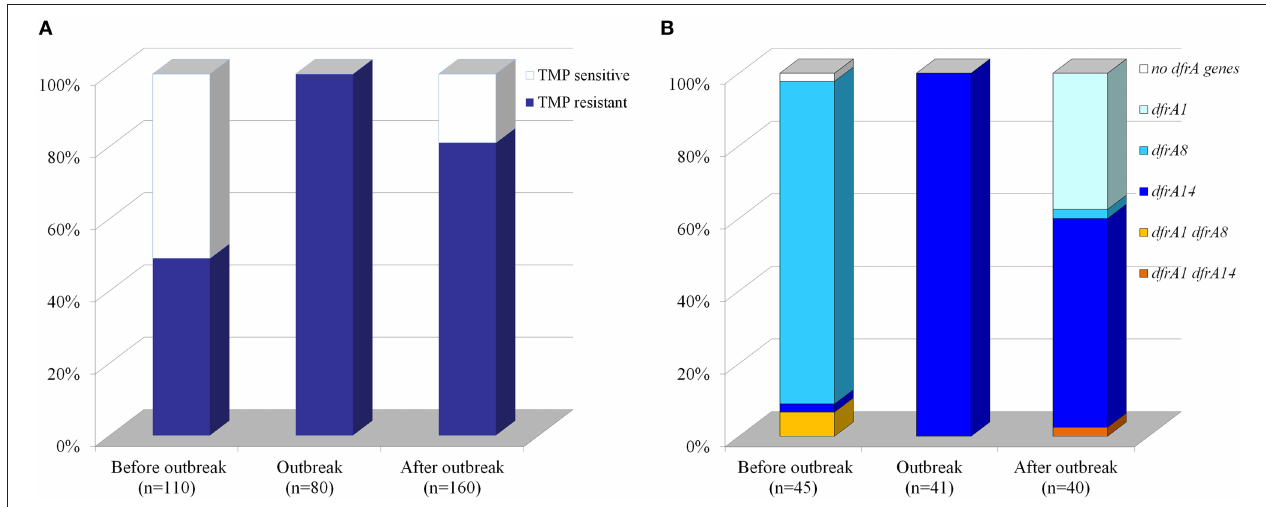
FIGURE 1 | Distribution of trimethoprim-resistant strains and trimethoprim-genetic markers among Chilean Shigella sonnei isolates. (A) Percentage of TMP-susceptible and–resistant strains. Susceptibility to TMP was measured by disk diffusion in a total of 350 strains isolated before, during or after the 2008–2009 outbreak. A total of 264 strains were TMP R including the 80 strains obtained during the outbreak. (B) Percentage of strains harboring TMP-resistance genetic markers. Presence of dfrA1 , dfrA8, and dfrA14 was assessed by PCR in a smaller group (126 strains) randomly selected from TMP R S. sonnei strains.